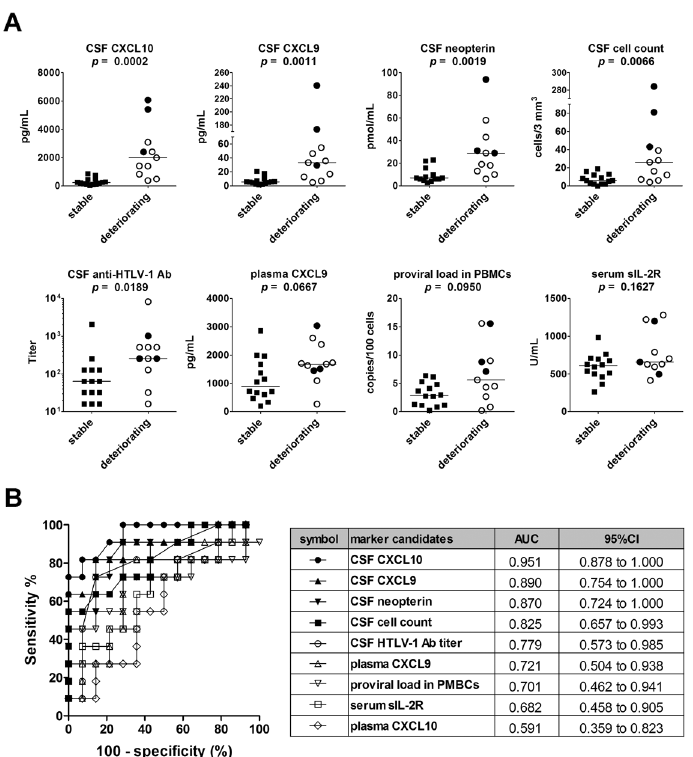
Figure 3. Identification of biomarkers associated with clinical progression of HAM/TSP. ( A ) Five CSF marker candidates (CXCL10, CXCL9, neopterin, cell count, and anti-HTLV-1 antibody titer) and four blood marker candidates (proviral load in PBMCs, serum sIL-2R, plasma CXCL9, and plasma CXCL10) were compared among a cohort of patients called the Training Set (deteriorating HAM/TSP, n=11; stable HAM/TSP, n=14). Data is shown for the top eight CSF markers ranked according to the significance of the difference between the deteriorating and stable subjects. Black circles indicate patients with particularly rapidly progressive HAM/TSP. Horizontal bars indicate the median values. The Mann-Whitney U -test was used for statistical analysis. ( B ) ROC analysis was employed to assess the sensitivities and specificities of the nine markers listed above for discriminating deteriorating HAM/TSP patients from stable patients. AUC=area under the ROC curve; 95% CI=95% confidence interval.